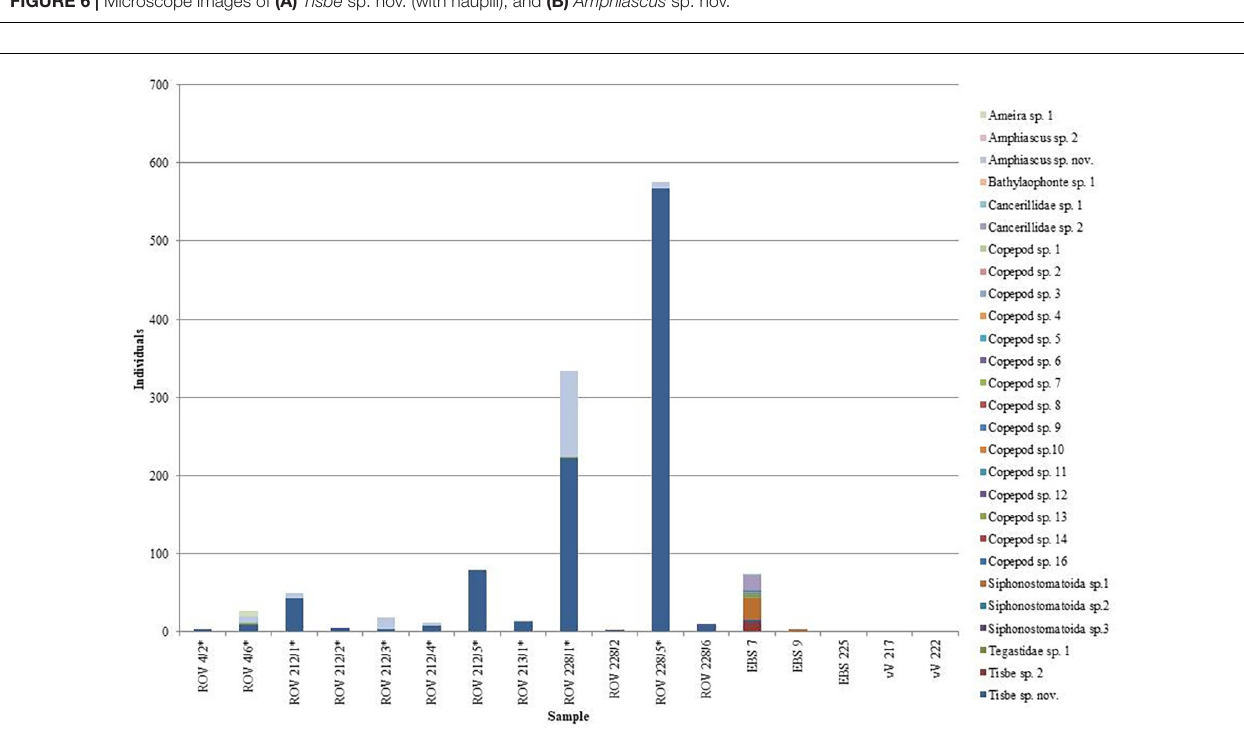
FIGURE 7 | Total individuals of Copepoda, Harpacticoida species taken during biological sampling during ROV, EBS, and vV deployments.